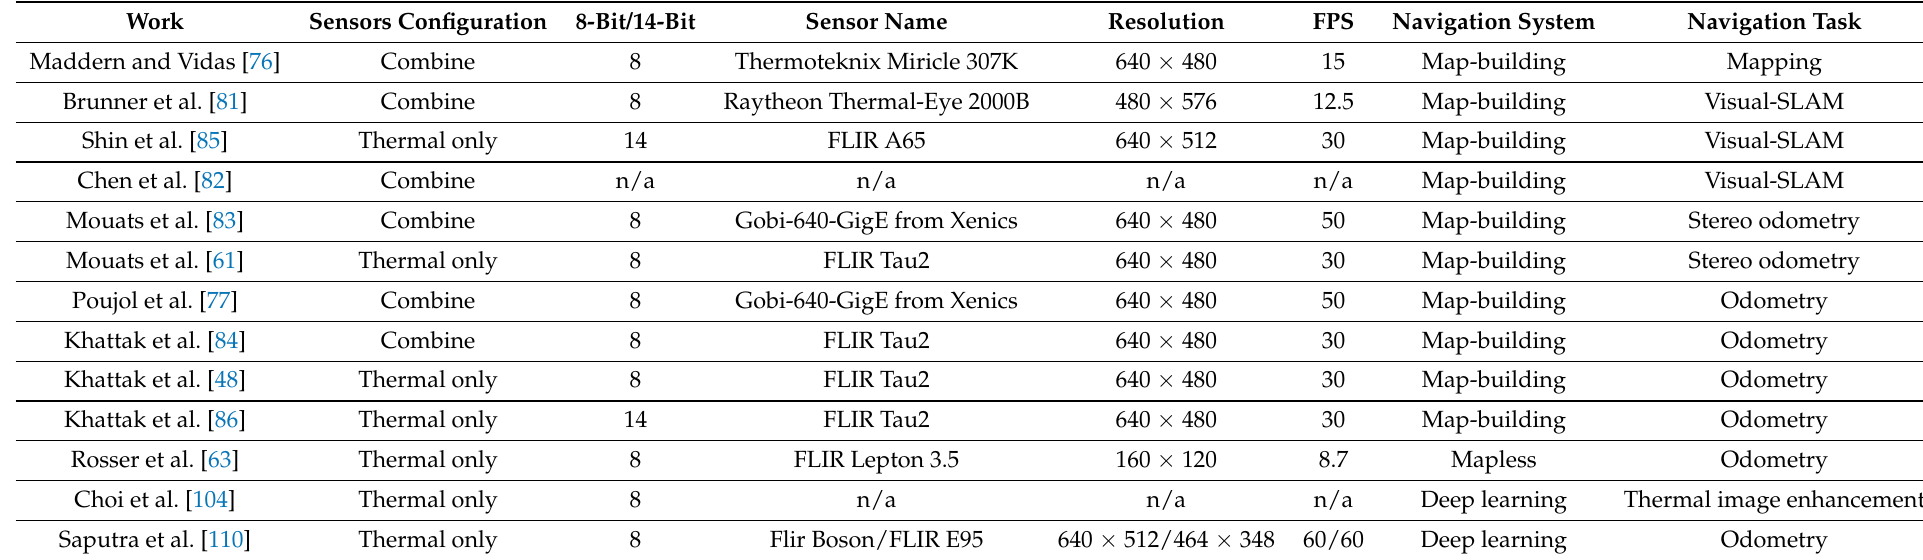
Table 4. Summary of presented